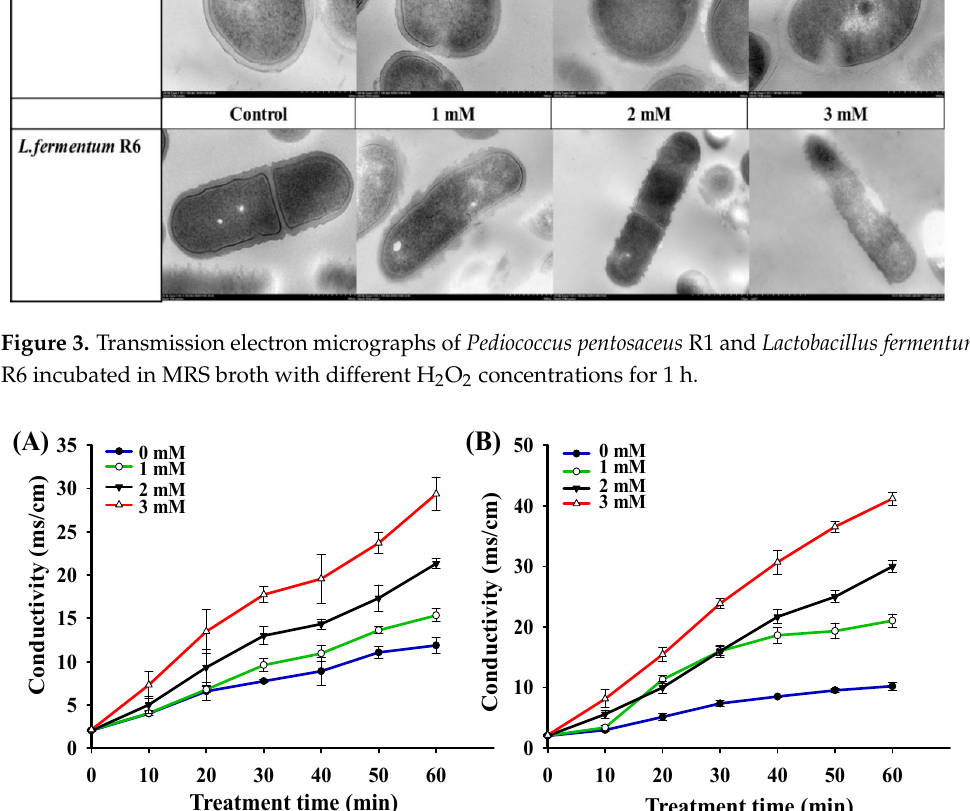
Figure 4. Analysis of electric conductivity of Pediococcus pentosaceus R1 ( A ) and Lactobacillus fermentum R6 ( B ) treated with different H 2 O 2 concentrations for 1 h.